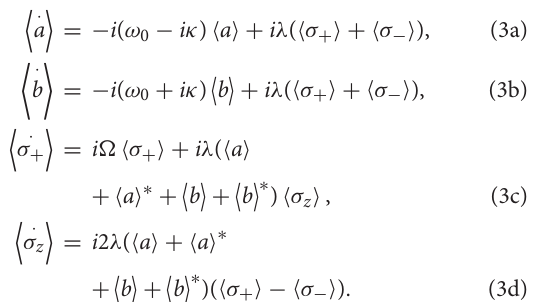
ω b ω 0 , λ a λ b λ , and κ a = = = = h = ¯